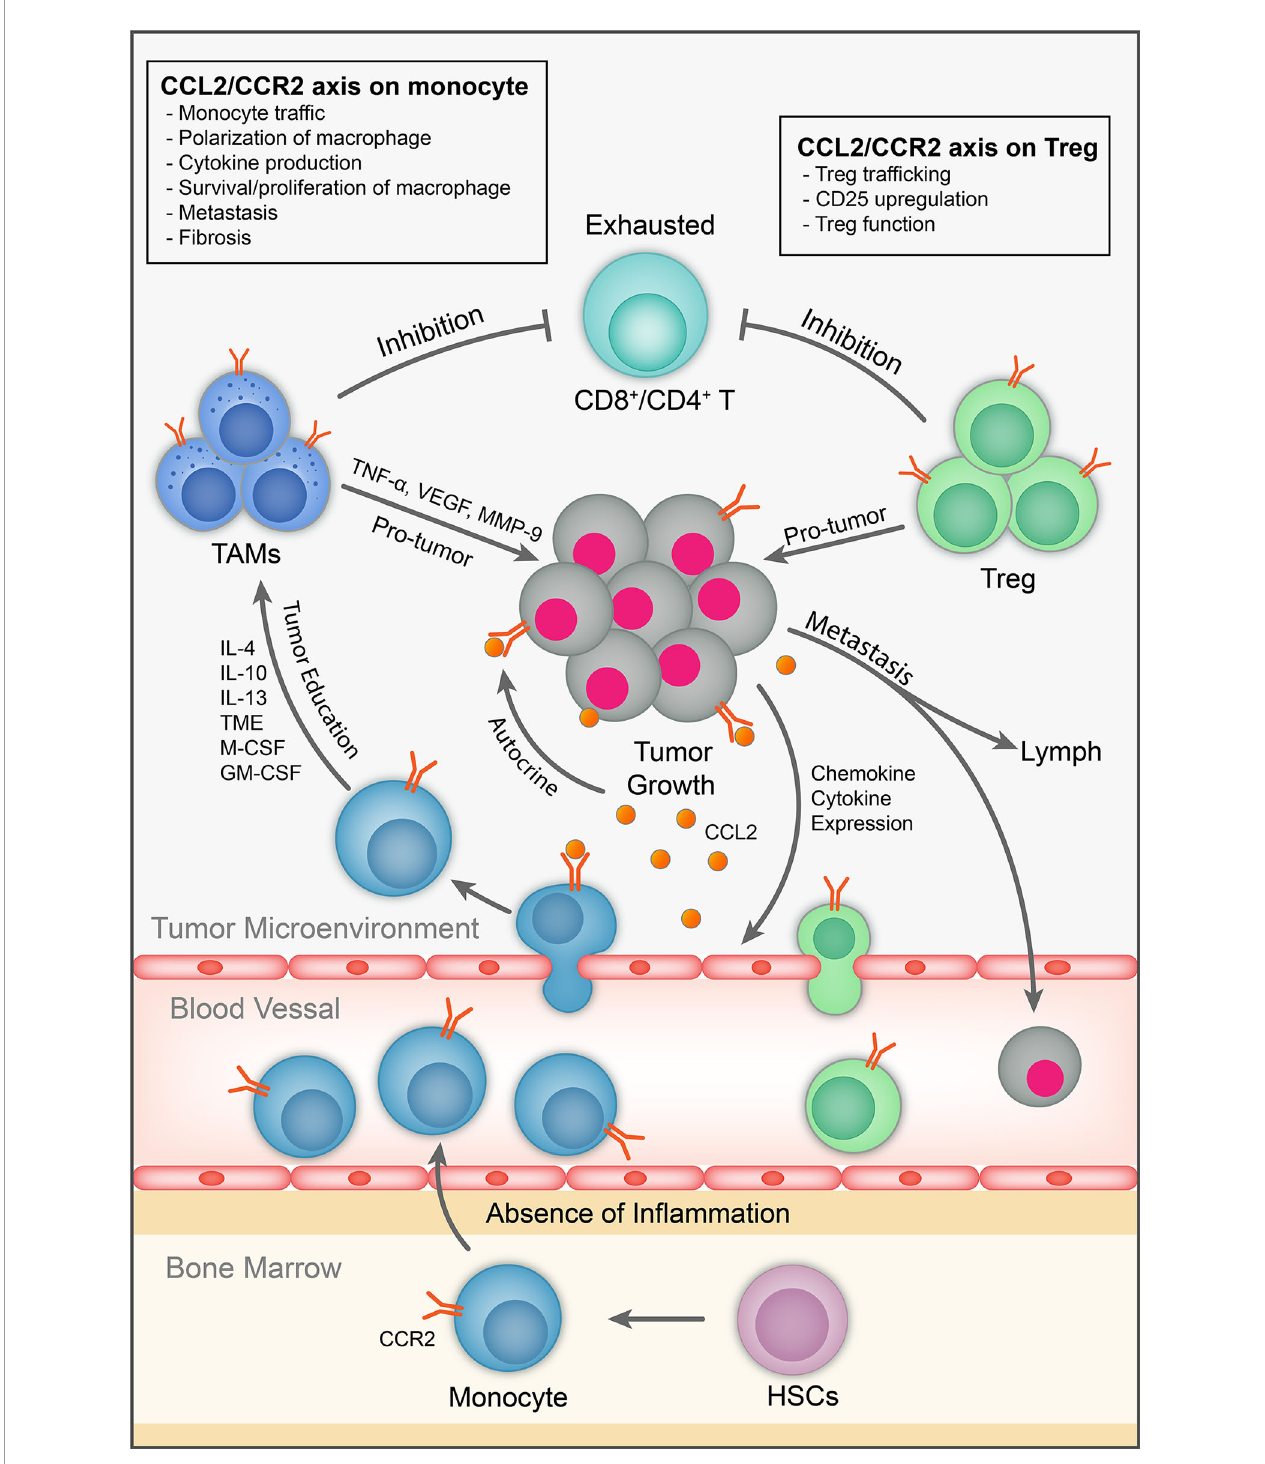
FIGURE 2 | The role of CCL2/CCR2 axis in tumor immunology. CCL2 is expressed by immune cells, cancer and stromal cells in the TME. It exhibits chemotactic and non-chemotactic effects on CCR2-expressing monocytes/macrophages. It also has chemotactic and non-chemotactic effects on CCR2-expressing T cells, particularly Tregs. It also induces tumor cell proliferation/survival and metastasis in autocrine and paracrine